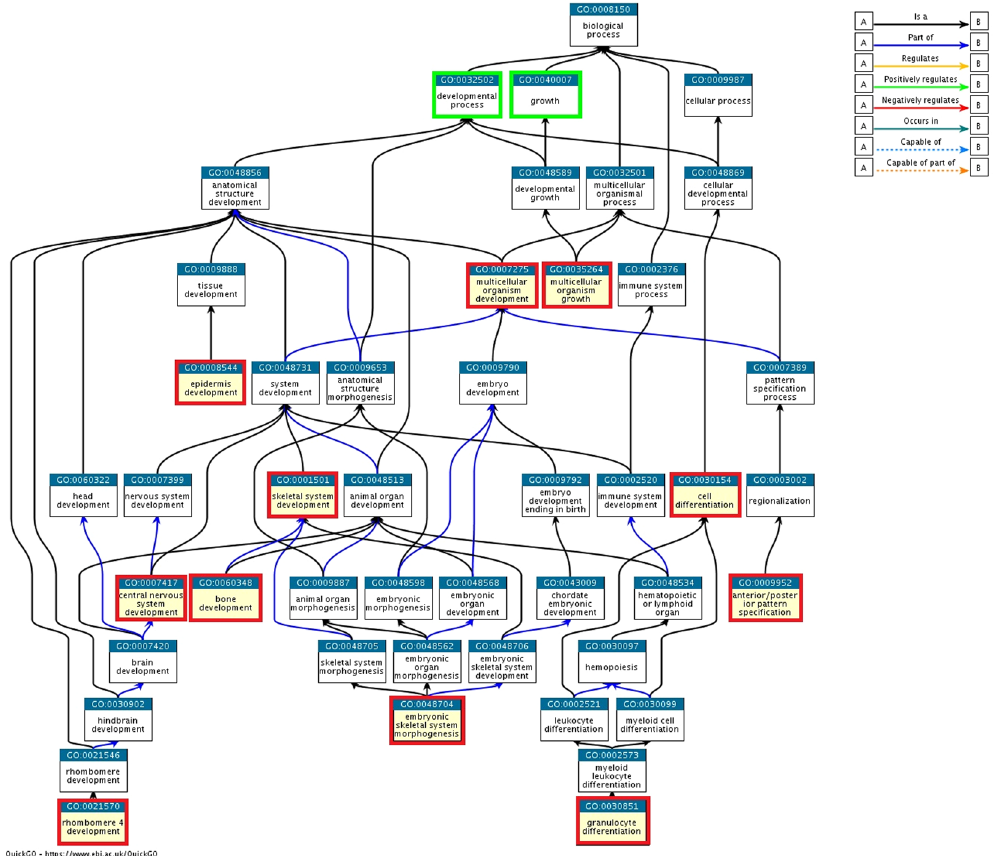
Figure 4. GO hierarchical structure for the eleven significantly enriched BPs (denoted with red color) associated with developmental process/growth term (denoted with green color). This GO tree was created and extracted by QuickGO 86